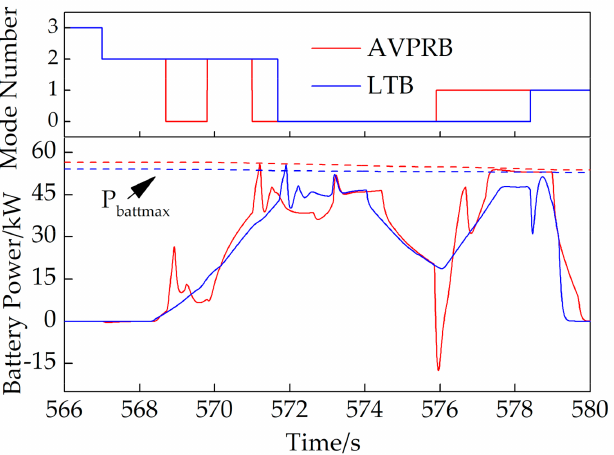
Figure 18. Battery power comparison between LTB strategy and proposed AVPRB strategy.